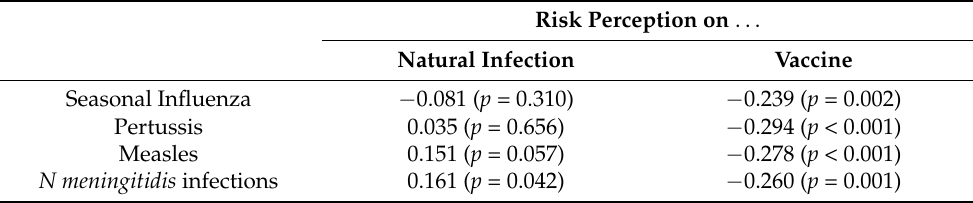
Table 3. Correlation between general knowledge score and risk perception score for natural infection and vaccination for the four assessed vaccine-preventable diseases. The analyses were performed via calculation using Spearman’s rank correlation coefficient. Risk Perception on . . . Natural